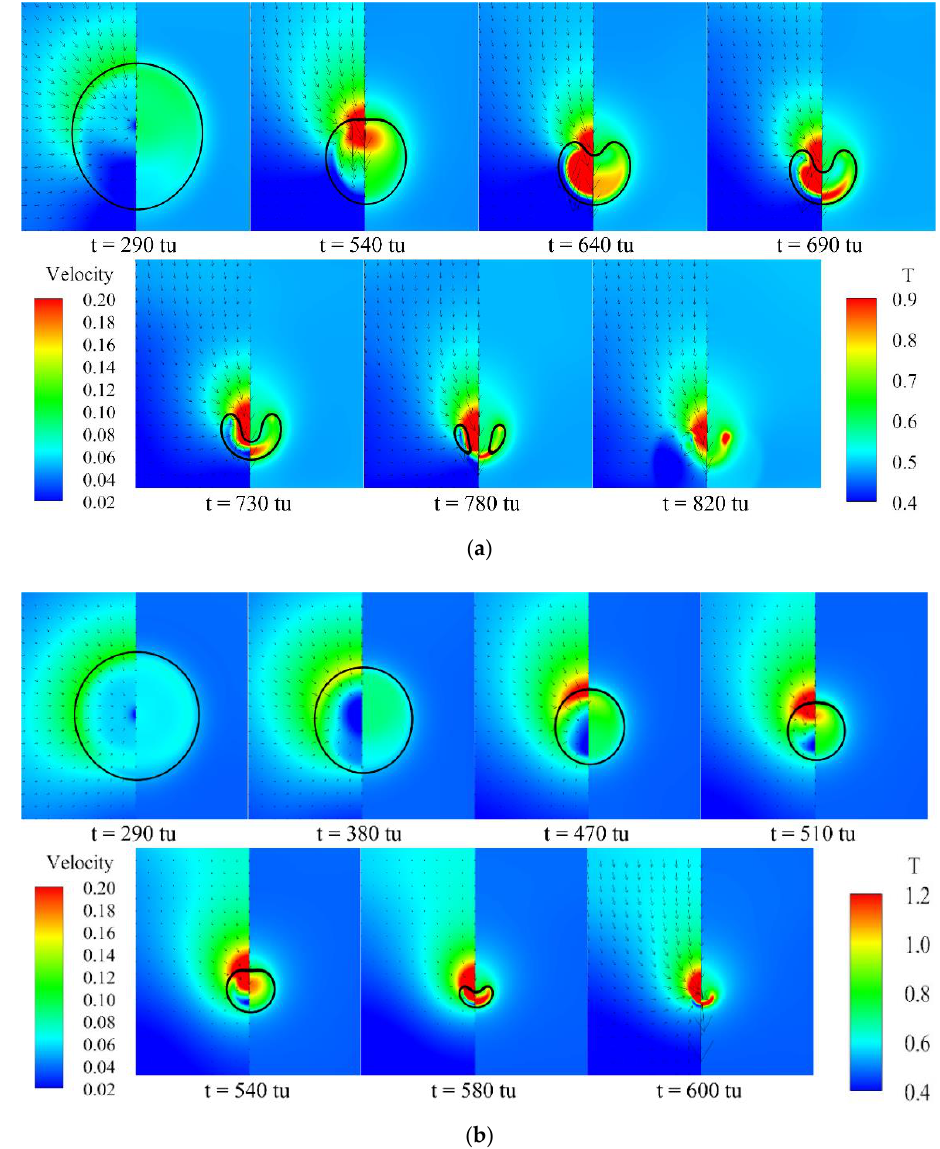
Figure 7. The predicted velocity and the temperature fields of bubble collapse process with differ- ent positions. ( a ) λ = 1.4; ( b ) λ = 2.4. positions. ( a ) λ = 1.4; ( b ) λ =